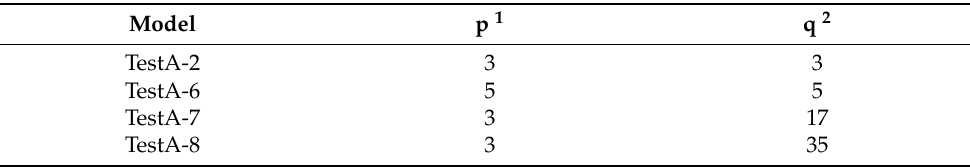
Table 2. Lateral loading